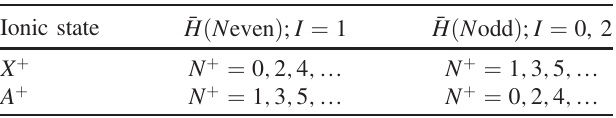
TABLE II. Selection of specific partial waves of the half collision of ortho- and para-D 2 þ by carrying out the multiphoton excitation sequence through selected rotational levels ( N ) of the ¯ H 1 Σ þ v ¼ 12 Þ state. g ð